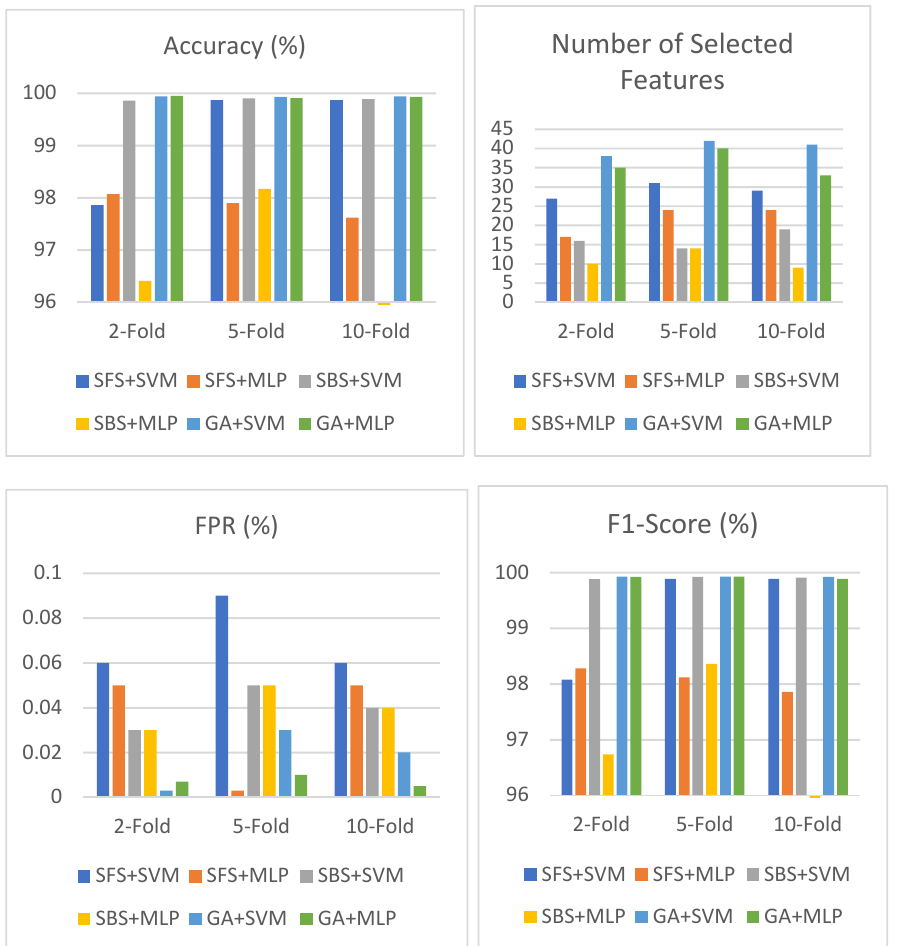
Figure 10. Performance of SFS, SBS, and GA using objective function based on DR, FPR, and number of selected features in CIC-IDS-2017.